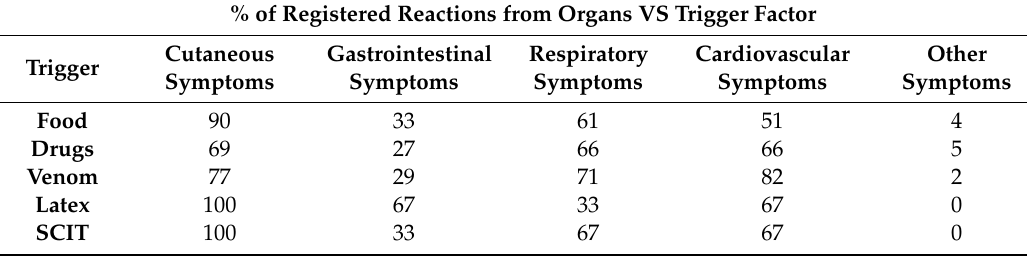
Table 3. Type of anaphylactic reaction vs. triggers.